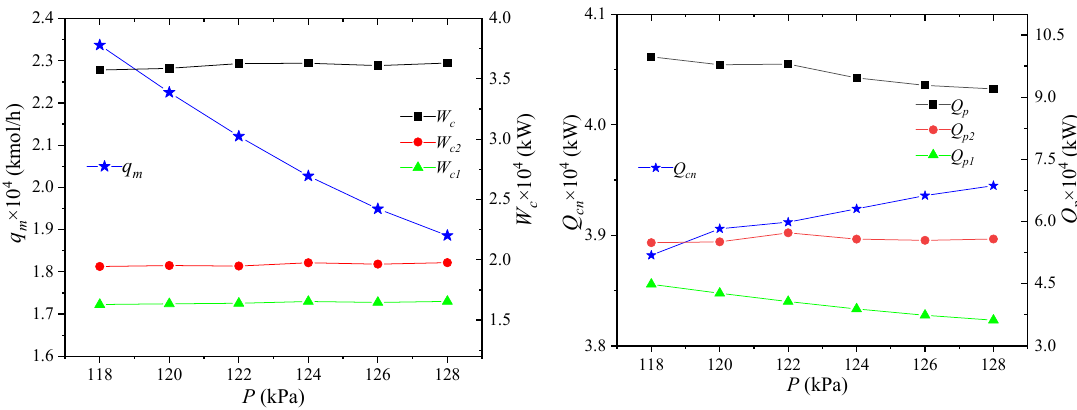
Figure 5. Effects of NG temperature on process performance.